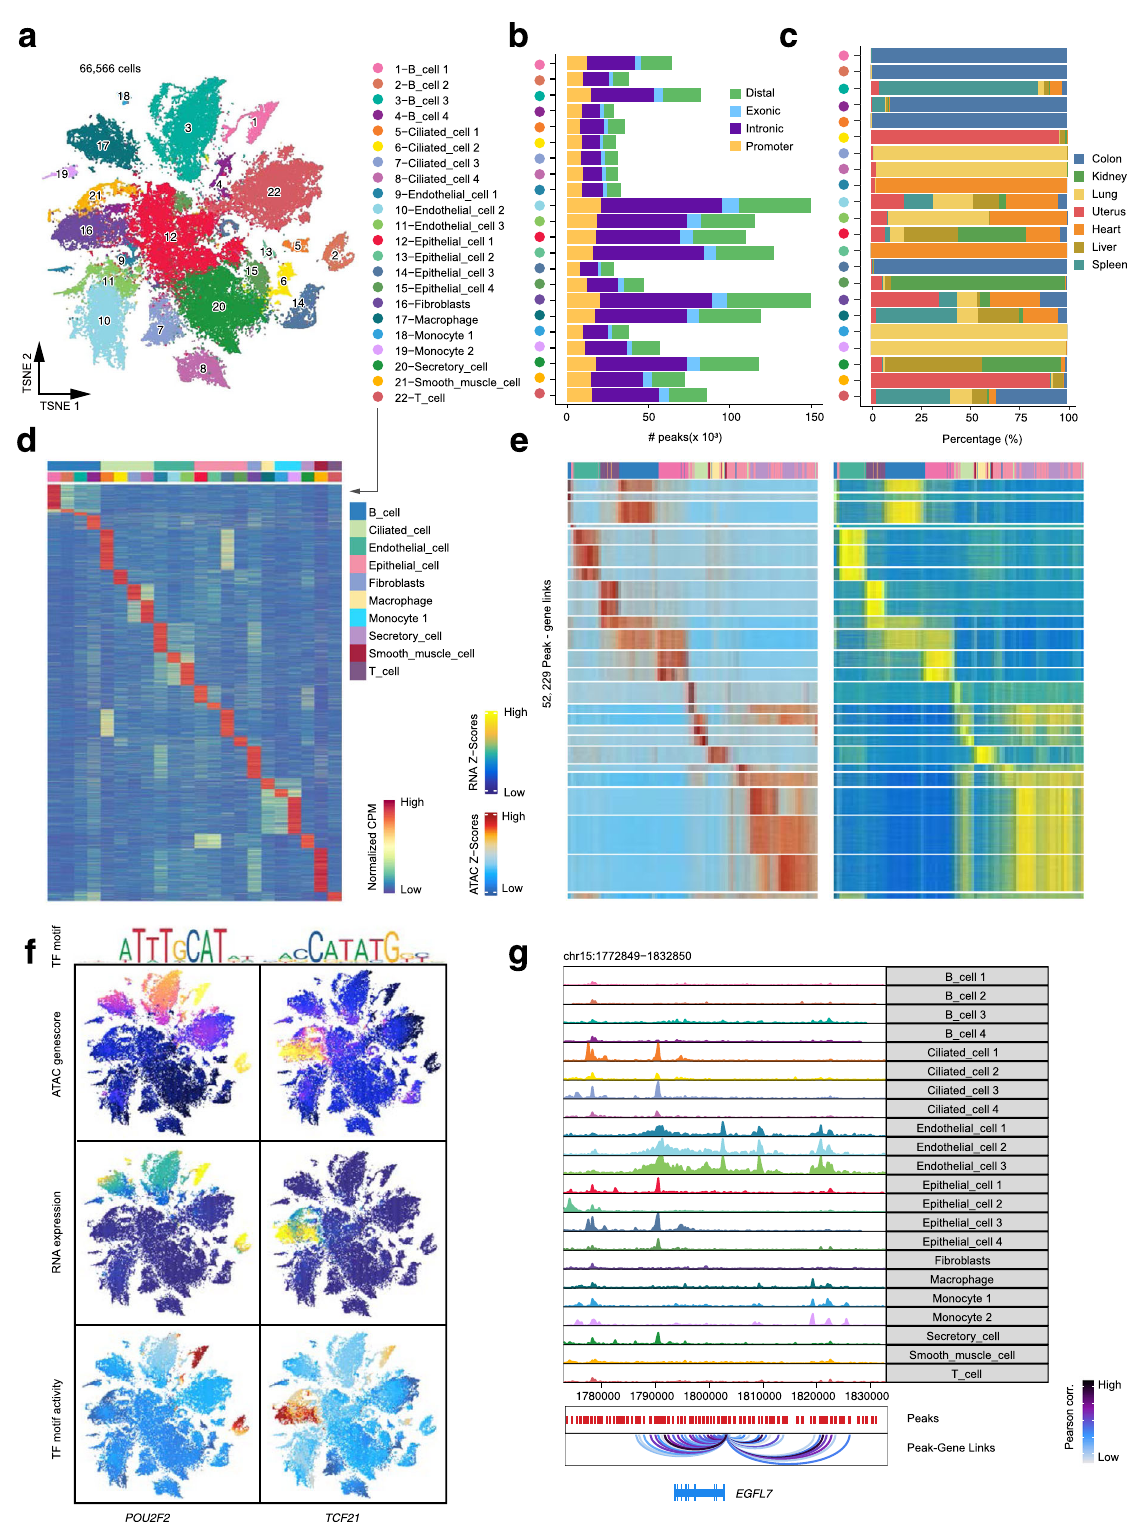
Fig. 6 Single-cell chromatin landscape of major organs in cynomolgus monkeys. a scATAC-seq data analysis revealing 66,566 cells and 22 cell subtypes. Shown is the t-SNE of cells colored by cell subtypes. b Bar plot showing the number of reproducible peaks identi fi ed from each cluster. The peaks are classi fi ed into four categories: distal, exonic, intronic and promoter. c Bar plot dhowing the percentage of cell subtypes in each organ. d Heatmap of 80,270 marker peaks across 22 subclusters identi fi ed by bias-matched differential testing (FDR < 0.01 and log 2 FC > 3). e Heatmap illustrating the chromatin accessibility and gene expression of 52,229 signi fi cantly (Pearson correlation r > 0.45 and adjusted p -value < 0.1, provided by chromVAR) linked peak-gene pairs. f Pro fi le of POU2F2 and TCF21 chromatin accessibility, gene expression (inferred from scRNA-seq) and TF motif activity. g Visualization of the EGFL7 locus with the maximum number of peak-gene pairs shown by genome browser track (chr15: 1,772,849-1,832,850).